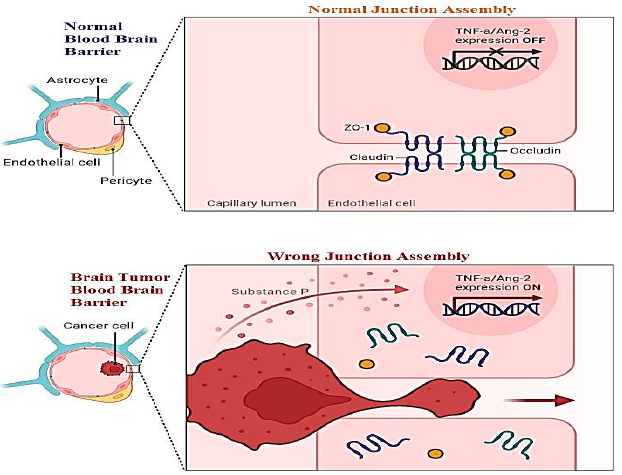
Figure 9. Entry of DNA vaccines into the nucleic acid region for their activation as compared to mRNA vaccines for which the cytosol area is enough for activation [102,103].